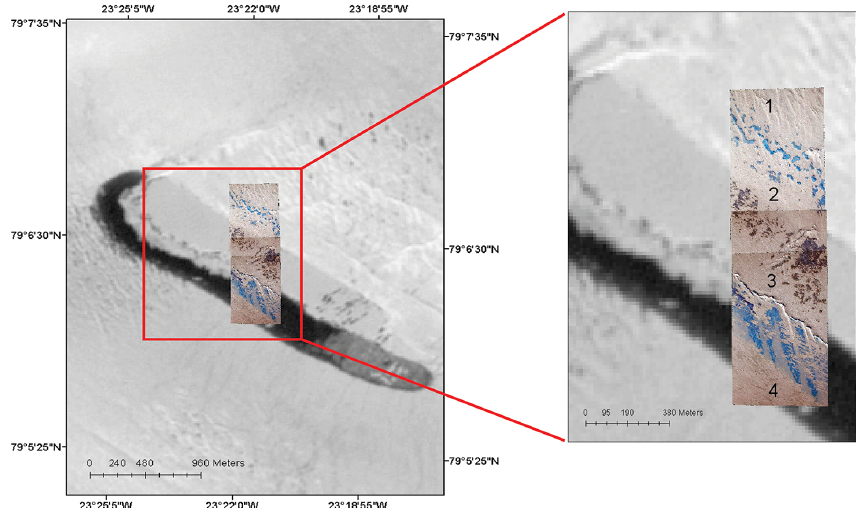
Figure 7. Image comparison of 2 May 2011 DMS image for the buried lake in Fig. 6 superimposed over a Landsat ETM + image acquired on 19 July 2011, well into the melt season, when a supraglacial lake had formed. Expanded images are of the same location over the section of the lake where the early season radar data showed initial surface melt. The lake extent correlates with the early season melt area (between locations 3 and 4) and the area of stored water maintained a floating ice cap into the melt season (between locations 2 and 3).